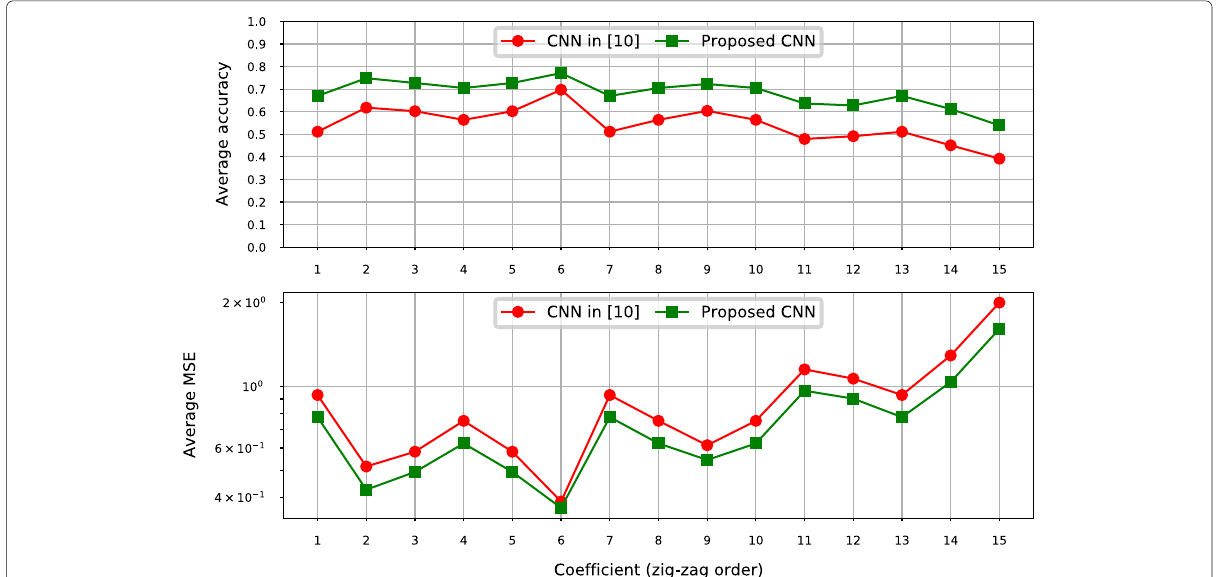
Fig. 3 Average accuracy (top) and average MSE (bottom) of the estimation for each of the 15 DCT coefficients, for QF 2 = 90, in the non-aligned DJPEG scenario